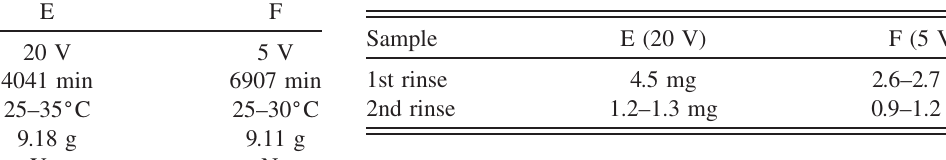
TABLE IV. Mass of impurities found after chloroform extrac-